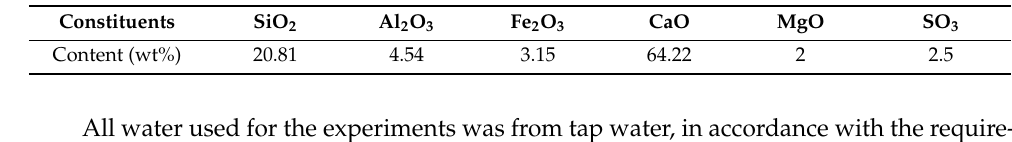
Table 1. Chemical composition of concrete.